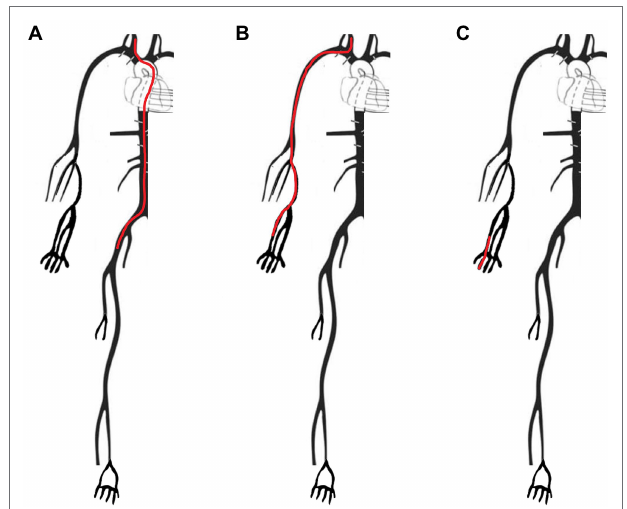
FIGURE 3 | Arterial paths as measured in the different methods of the model, by adding up the lengths of the different segments. (A) Carotid- femoral path ( Δ x_cf) used for the calculation of the cfPWV, measured from the common carotid to the femoral artery via the external iliac. (B) Carotid-radial path ( Δ x_cr) used for the crPWV calculation, measured from the common carotid to the radial artery via the brachial artery. (C) Radial-digital path ( Δ x_rd) used for the rdPWV calculation, measured from the radial to the palmar digital